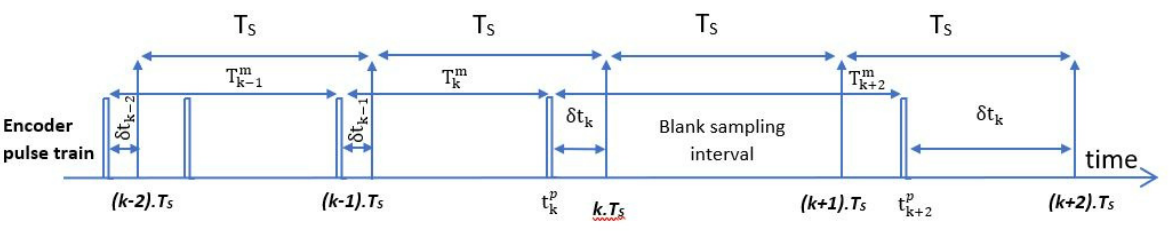
Figure 3. Sampling intervals for speed computation .